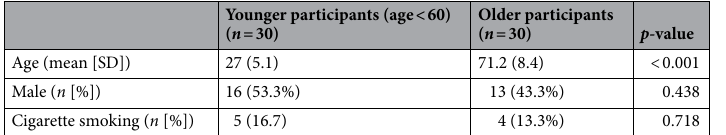
Table 1. Descriptive values of age, sex, and smoking status. The difference in age was assessed with independent t tests, the difference in the other (categorical) variables with χ 2